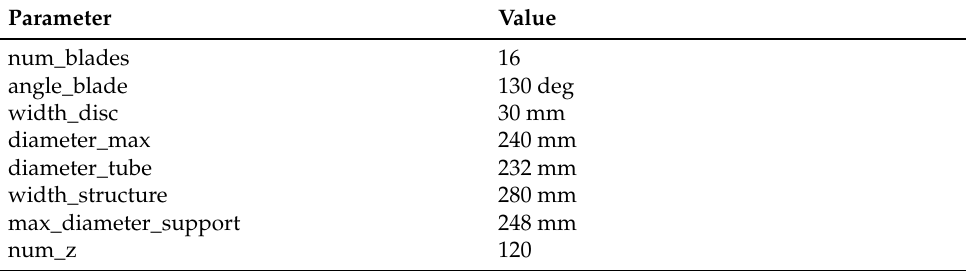
Table 2. List of parameters of the current version for eight-inch